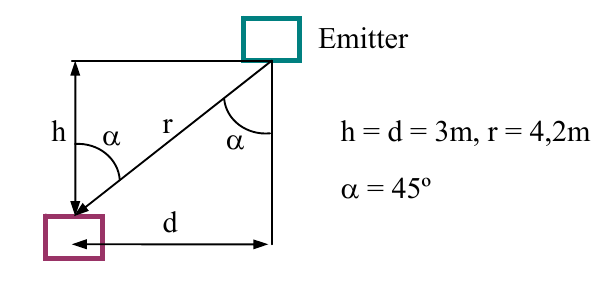
Figure 18 . Worst case conditions.